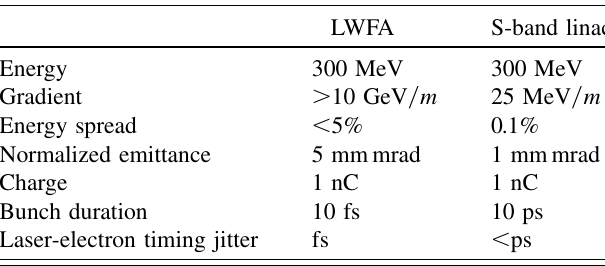
TABLE III. LWFA and linac parameters.